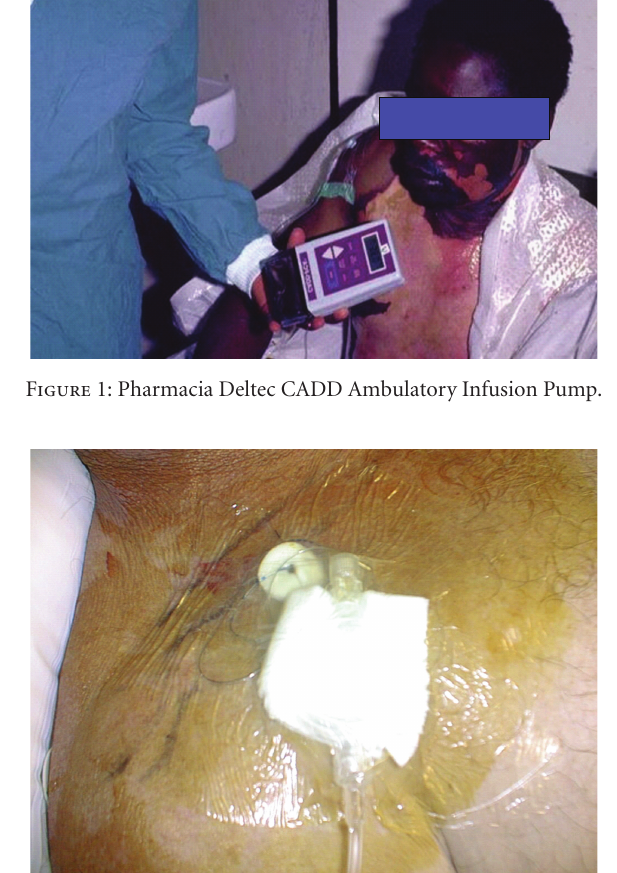
Figure 2: Patient-controlled perineural analgesia via infraclavicular brachial plexus catheter.